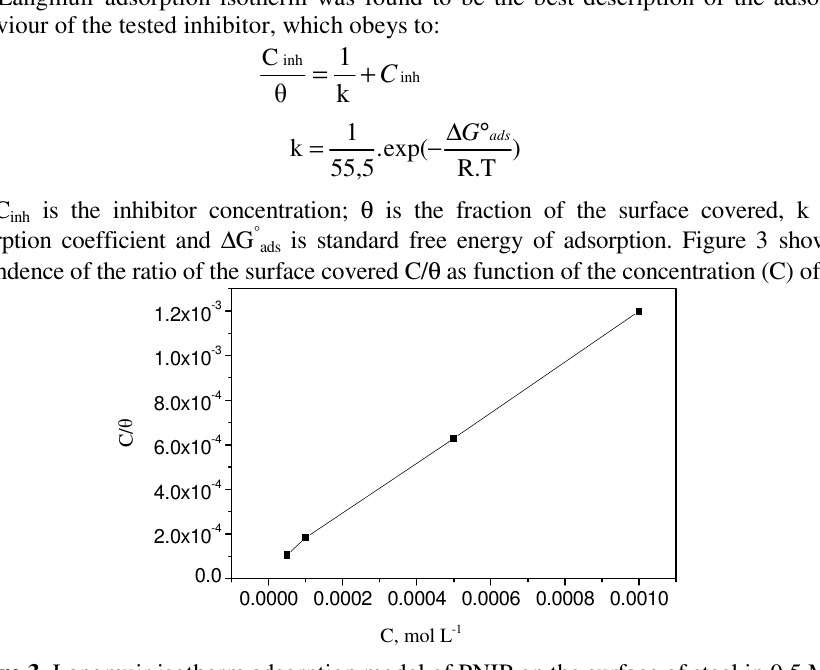
Figure 3. Langmuir isotherm adsorption model of PNIP on the surface of steel in 0.5 M HCl The obtained plot of inhibitor is linear with a slope 1.14 to close to unity. The regression coefficient is R = 0.9998. The intercept permit the calculation of the equilibrium constant k= 17030.7 M -1 which leads to evaluate ∆ G ° = -34.9 kJ/mol. The negative value ads of ∆ G ° indicates that the inhibitor is spontaneously adsorbed on the metal surface and ads shows also physical adsorption of PNIP 27